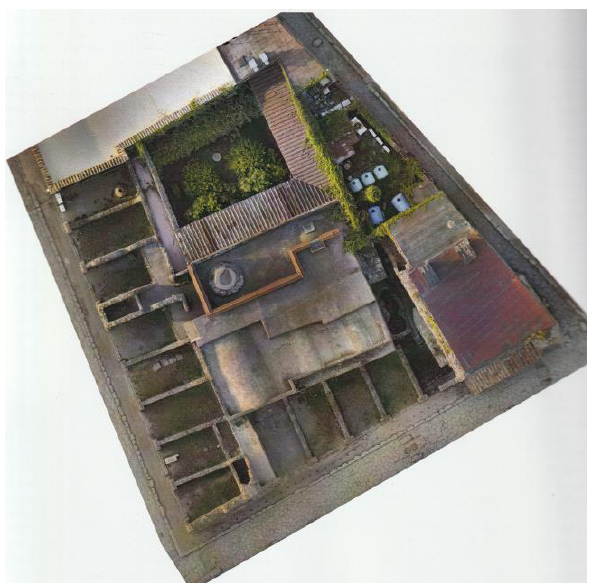
Figure 4. Forum Baths, orthophoto of the extrados of the roofs carried out through the use of a drone (Cicirelli, Brancaccio, Mangone, 2018).